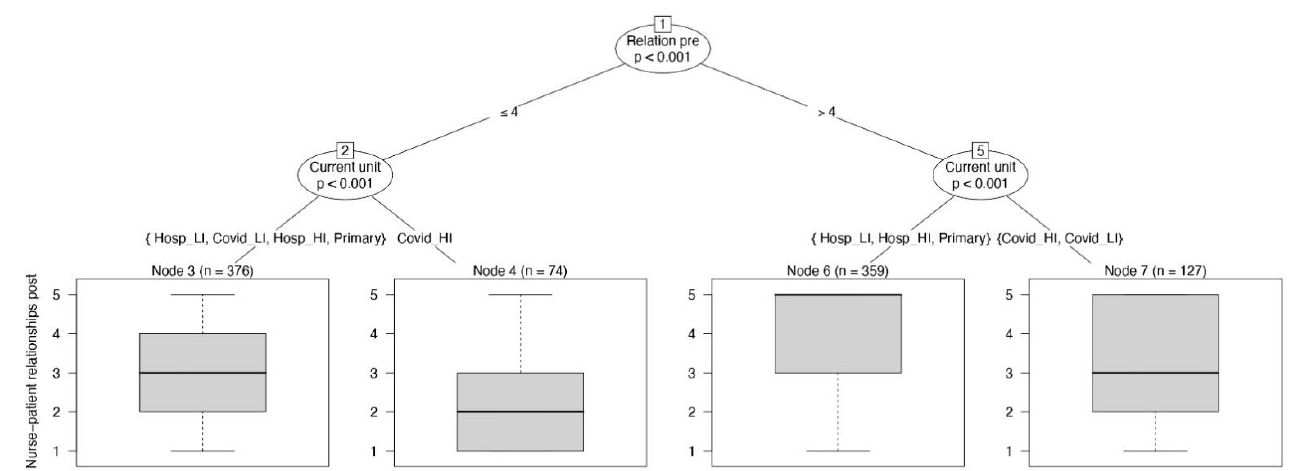
Figure 5. The conditional inference tree with the frequency of nurse–patient relationships as dependent variable, reported at the bottom of the figure as boxplot.